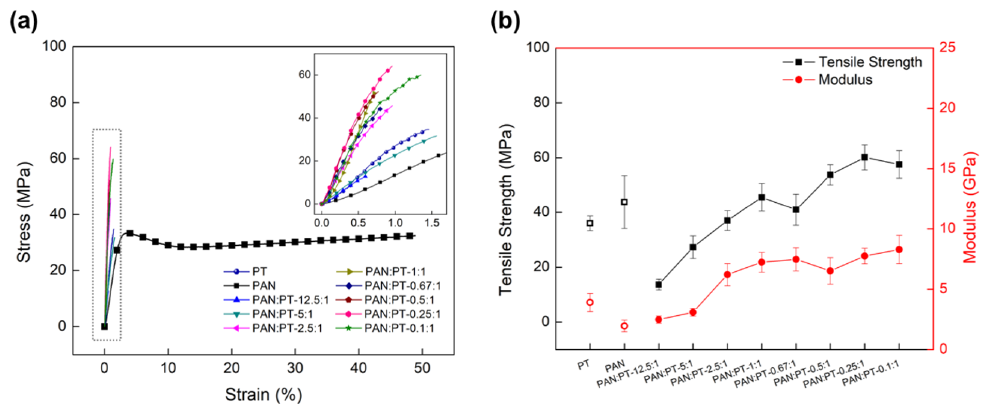
Figure 9. Tensile test results of PAN film, PT BP, and PANPT hPBPs with varying PAN weight concentrations, ( a ) representative engineering stress-strain (S-S) curves and ( b ) average values of tensile strength and